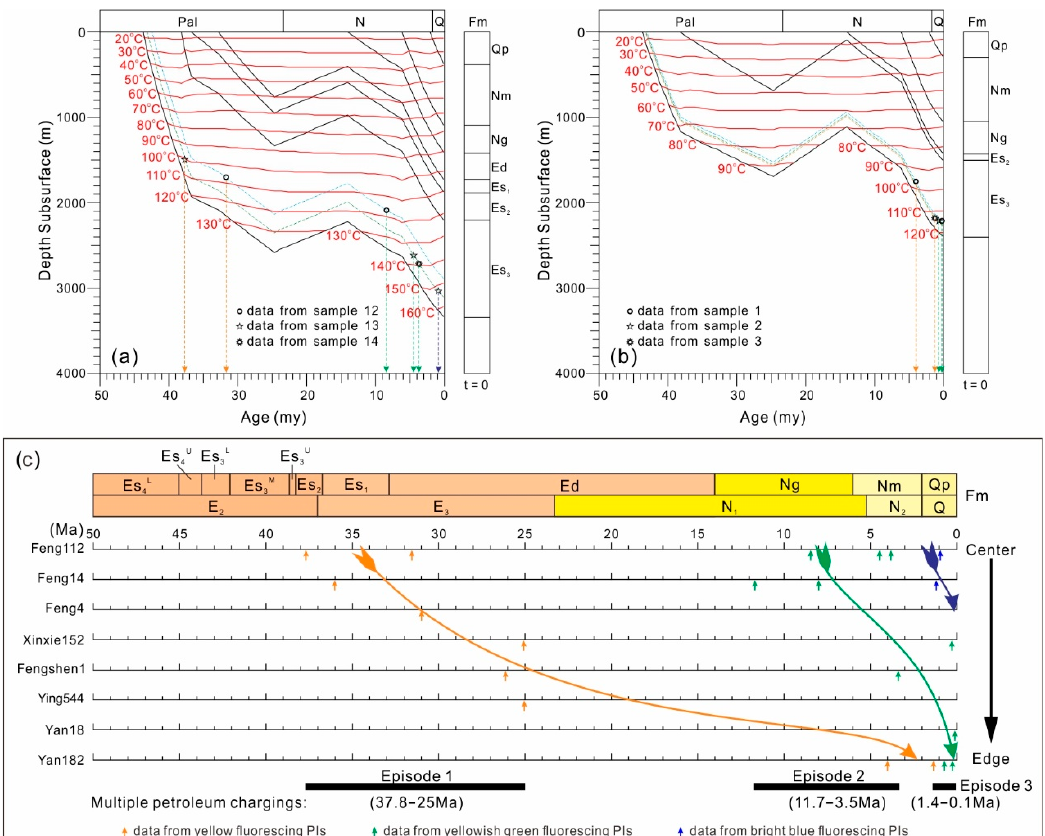
Figure 7. Determination of the hydrocarbon charging episodes and the corresponding time. ( a ) Tim- ing the petroleum chargings in the well Feng112, located in the center of the sag; ( b ) timing the petroleum chargings in the well Yan182, located at the edge of the sag; ( c ) classifying the petroleum charging episodes by integrating all the time data gotten from all the wells.